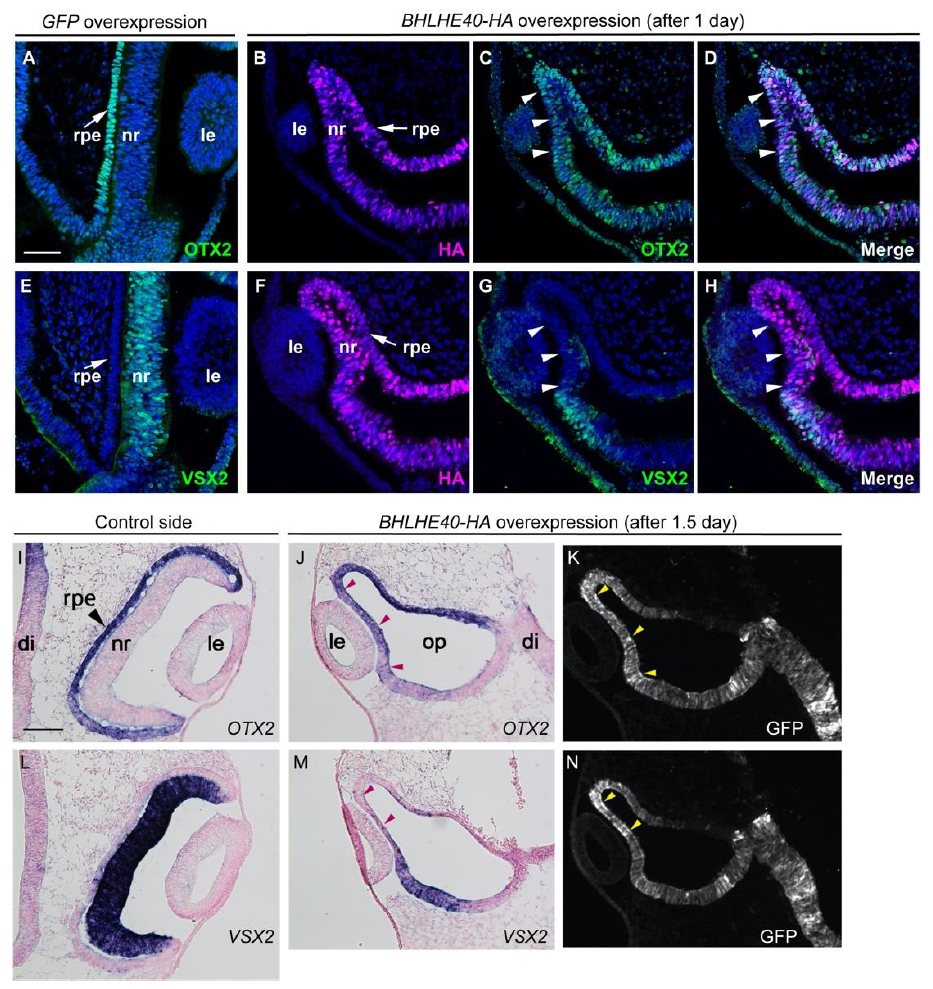
Figure 3. Expression pattern of OTX2 and VSX2 in the optic cup after GFP and BHLHE40 overex- pression. Frontal sections of the optic cup from three embryos ( GFP #2, BHLHE40 #14, BHLHE40 #17) are shown. Dorsal is to the up. ( A – H ) Optic cups at 1 day post electroporation (for GFP alone and HA-tagged BHLHE40 overexpression). ( A , E ) Immunofluorescence of OTX2 ( A ) and VSX2 ( E ) in GFP overexpression control (#2). ( B – D ) Immunofluorescence of HA ( B ) and OTX2 ( C ) in HA-tagged BHLHE40 overexpression (#14). Secondary antibodies to anti-HA and anti-OTX2 were Alexa Fluor 568-conjugated anti-rat IgG and Alexa Fluor 647-conjugated anti-rabbit IgG, respectively. ( D ) Merged image of ( B ) and ( C ). ( F – H ) Immunofluorescence of HA ( F ) and VSX2 ( G ) in HA-tagged BHLHE40 overexpression. Secondary antibodies to anti-HA and anti-VSX2 were Alexa Fluor 568- conjugated anti-rat IgG and Alexa Fluor 488-conjugated anti-sheep IgG, respectively. ( H ) Merged image of ( F ) and ( G ). Cell nuclei were stained with Hoechst 33342 ( A – H ). Similar data from another embryo (#11) are shown in Supplementary Figure S2A – H. ( I – N ) Optic cups at 1.5 days post electro- poration (HA-tagged BHLHE40 overexpression, #17). ( I , L ) Optic cups on the control side are shown. OTX2 is expressed in the outer layer of the optic cup ( I ), while VSX2 is expressed in the inner layer of the optic cup ( L ). In ( K , N ), co-electroporated GFP, showing the domain of BHLHE40 overexpres- sion. Images for GFP were taken before ISH. ( J , M ) In embryo #17, the inner layer of the optic cup abutting the lens, where BHLHE40 is ectopically expressed (arrowheads in J ), remains thin and ex- presses OTX2 ( M ). In the same domain, VSX2 expression is downregulated (arrowheads in M ). Cell nuclei were stained with nuclear fast red ( I – N ). di, diencephalon; le, lens vesicle; nr, neural retina; op, optic cup or deformed optic vesicle in ( G ); rpe, developing RPE. Scale bar: 50 μm in ( A ) for ( A – H ), 100 μm in ( I ) for ( I – N ).